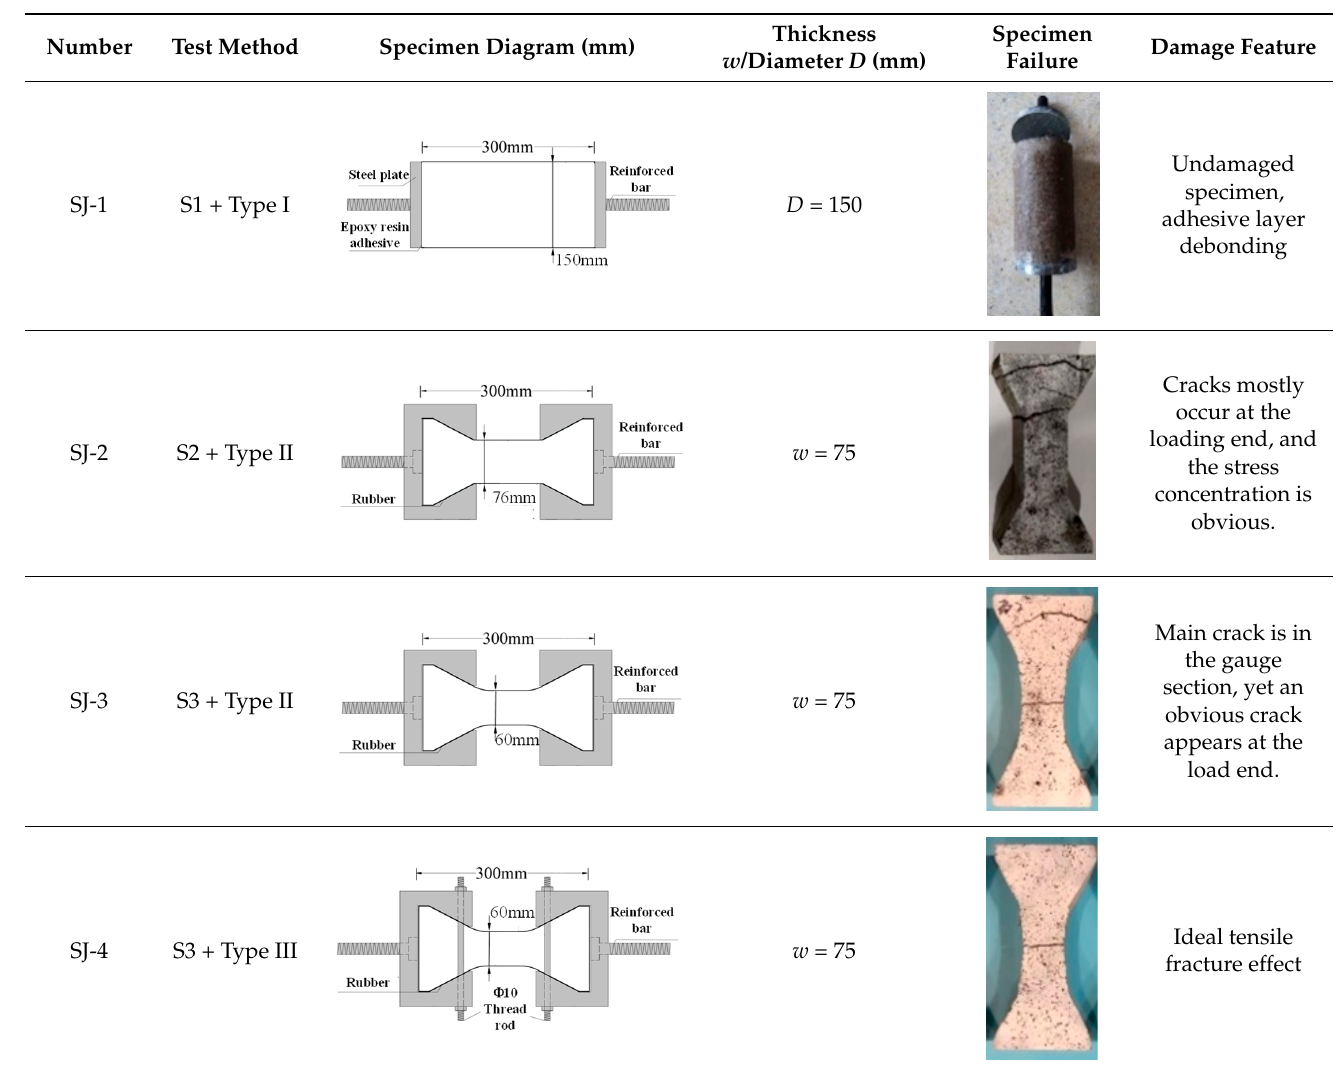
Figure 6. Direct tensile test fixture III (unit: mm).